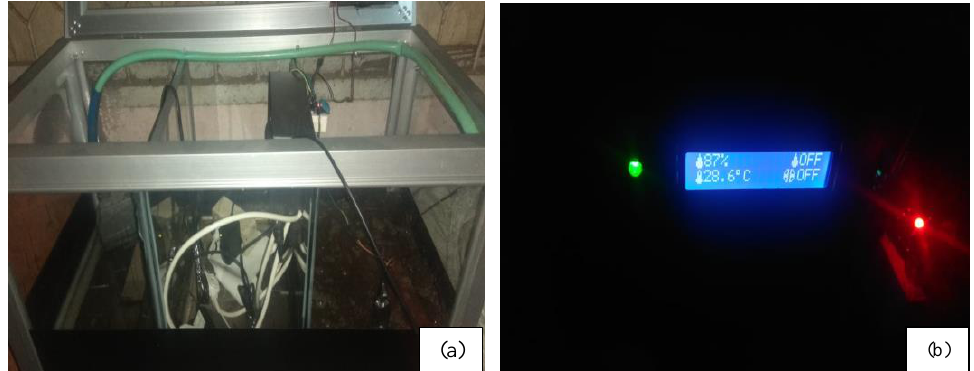
Figure 1. (a) Installation of Design Monitoring System; (b) Greenhouse display before sending to